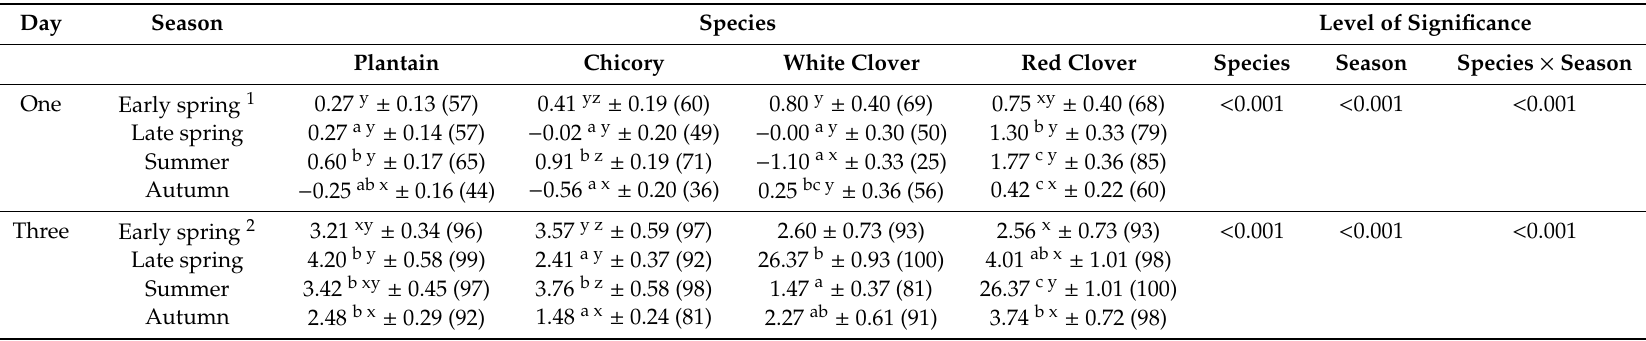
Table 5. Proportional selection by the chicory mix lambs of a tagged species, plantain, chicory, white clover and red clover on day one and three during di ff erent seasons (logit lsmeans ± SEM, back transformed percentages (%) are given in